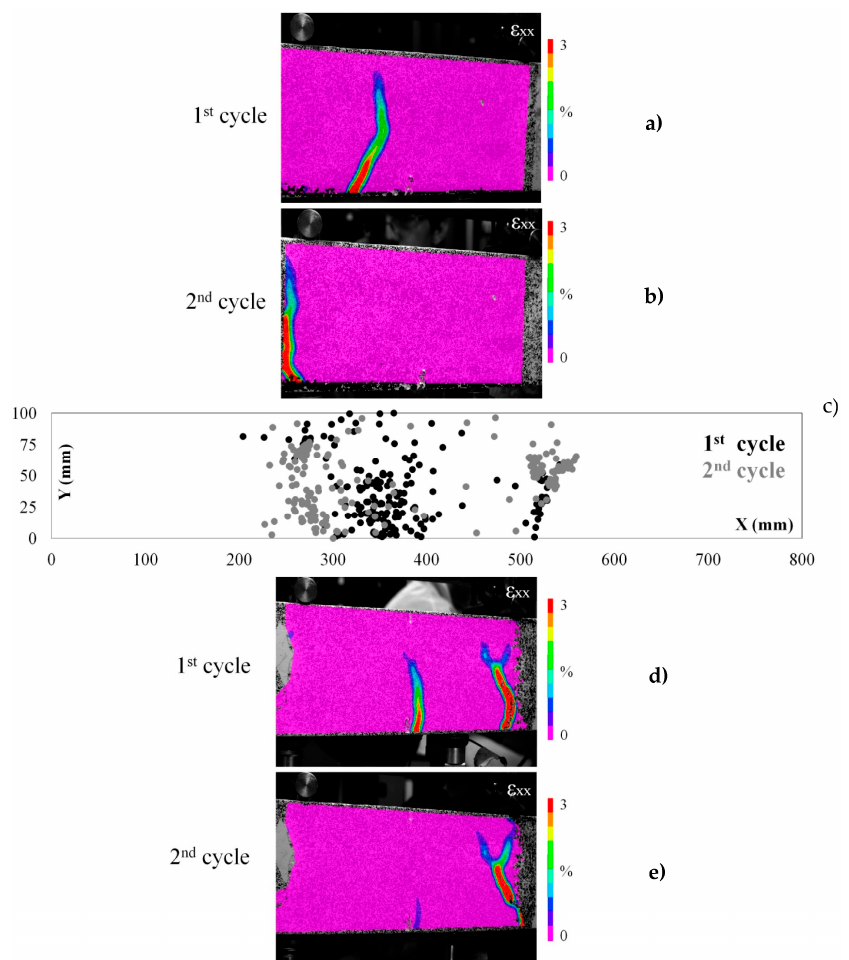
Figure 11. ( a , b ) The strain ( ε xx ) maps of beam carrying cementitious (IPC) network healing system at loading and reloading test cycles; ( c ) the AE events location map (X versus Y coordinates) is given for the first beam; and ( d , e ) the strain ( ε xx ) maps of a second beam with the same healing system.